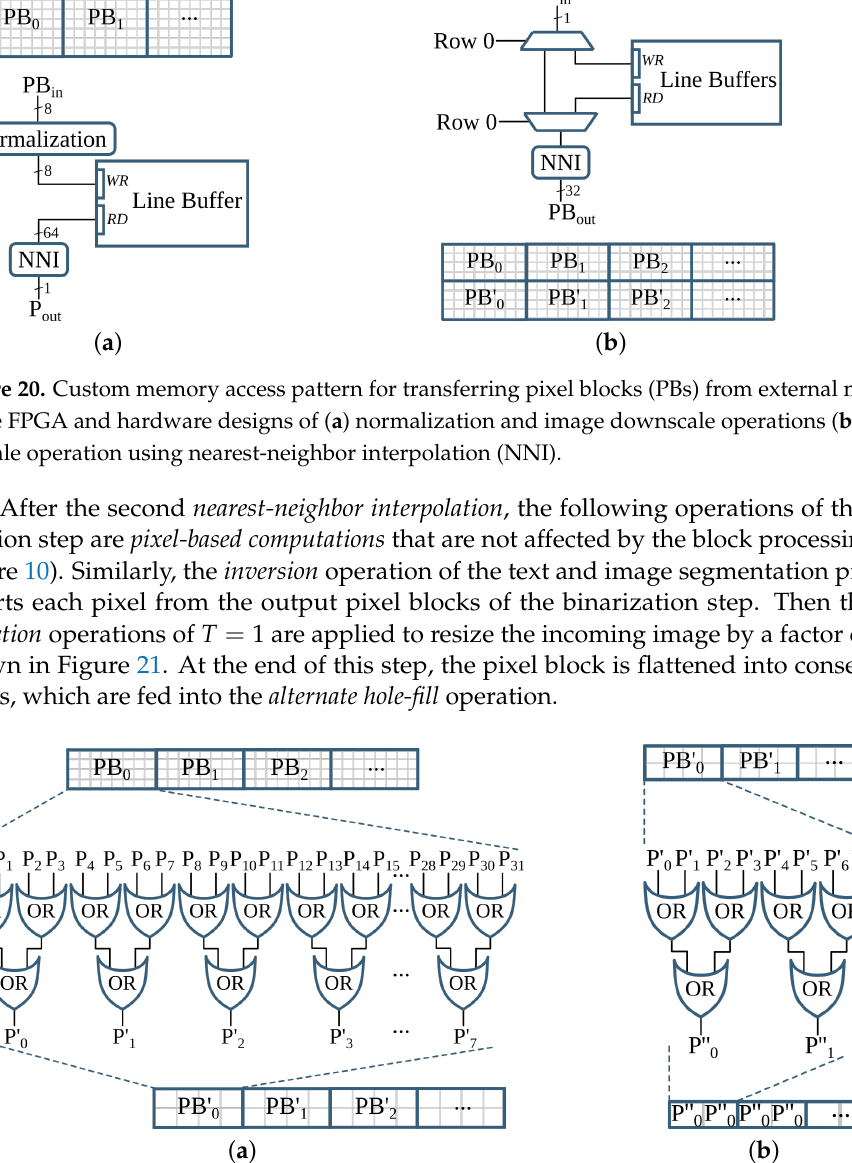
Figure 21. Hardware architecture for the two consecutive reduction operations. ( a ) first reduction with T = 1 ( b ) second reduction with T =